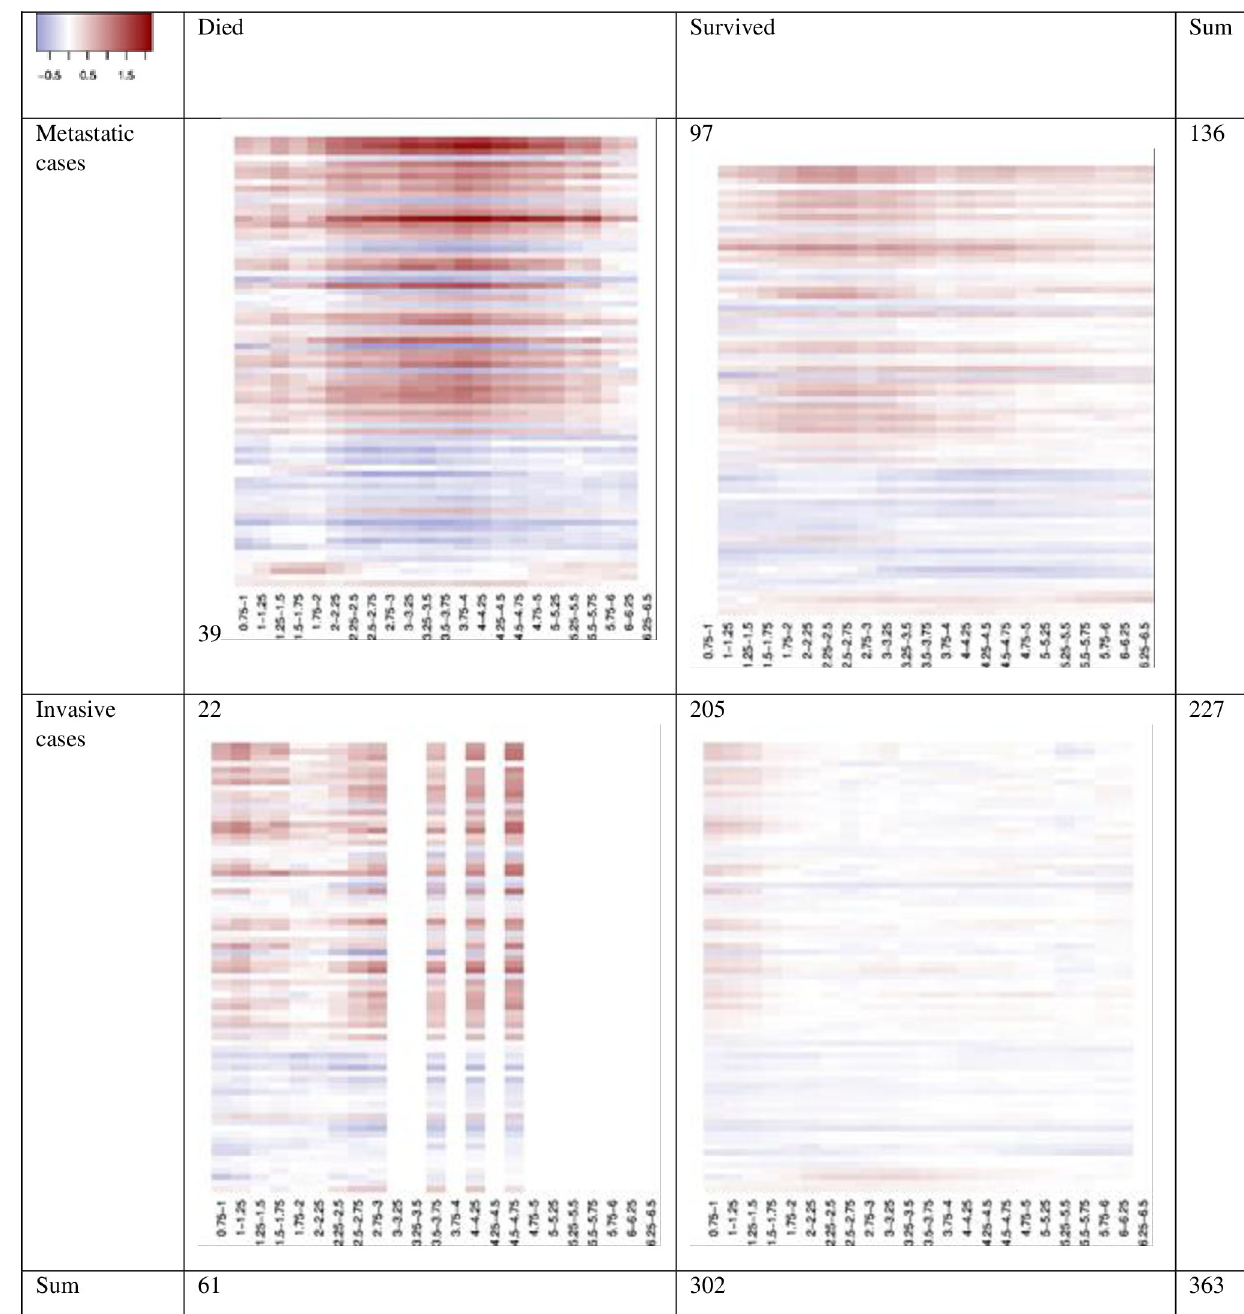
Fig 5. Heat maps with 74 selected genes in each stratum; invasive versus metastatic, and death or survival, at end of follow-up. The 50 topmost genes in the heat maps are the 50 top genes for the metastatic cases that died, the next 19 are the significantly up-regulated or down-regulated genes for the metastatic cases that survived, and the last five are the significantly up-regulated or down-regulated genes for the invasive cases that survived. There were no significantly up-regulated or down-regulated genes for the invasive cases that died. The heat maps show log fold change for each gene (y-axis) for each quarter of the years after diagnosis